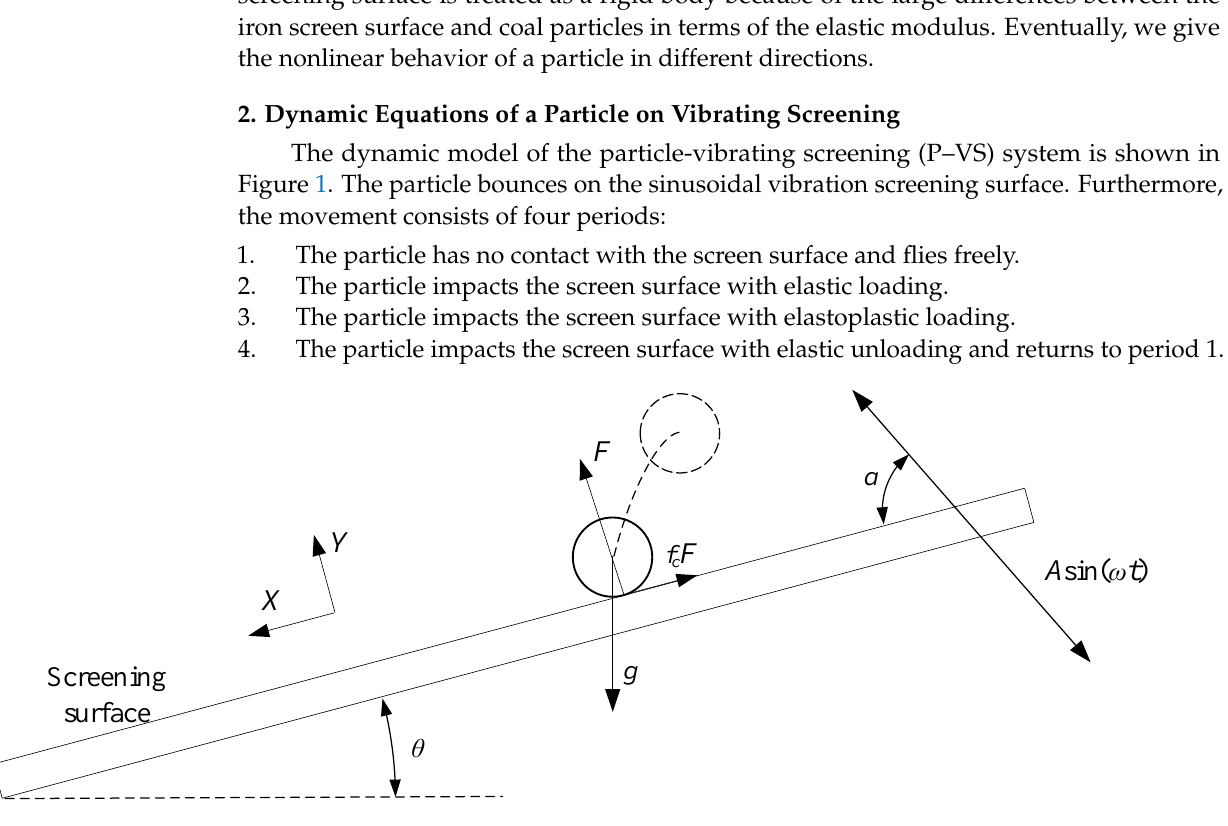
Figure 1. Dynamic model of the particle-vibrating screening system.